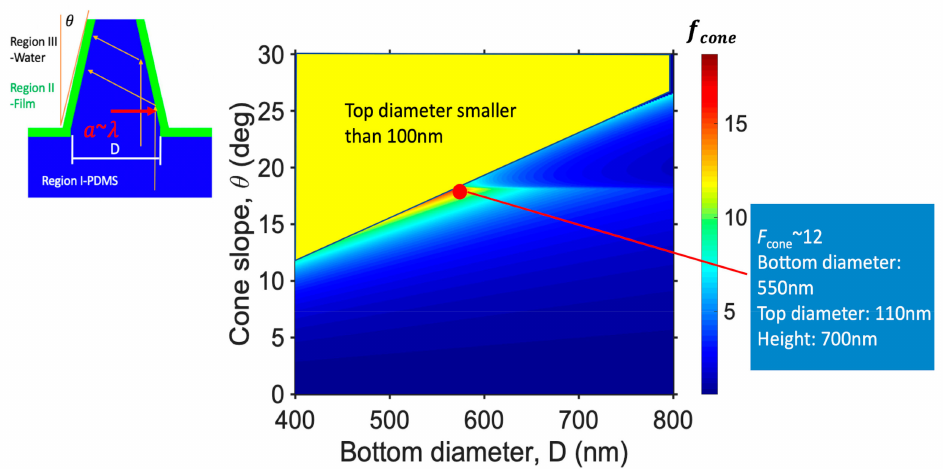
Figure 5. f cone as a function of bottom diameter and slope.